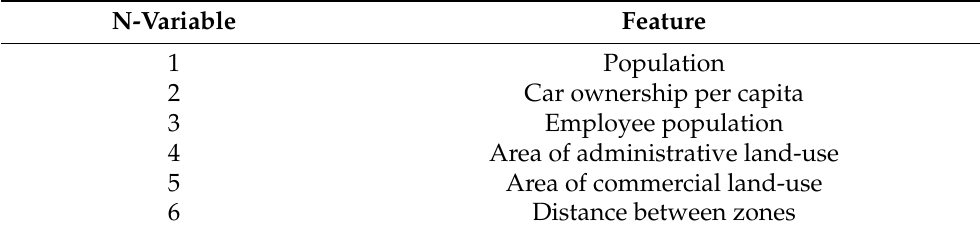
Table 1. Characteristics of traffic analysis zones.